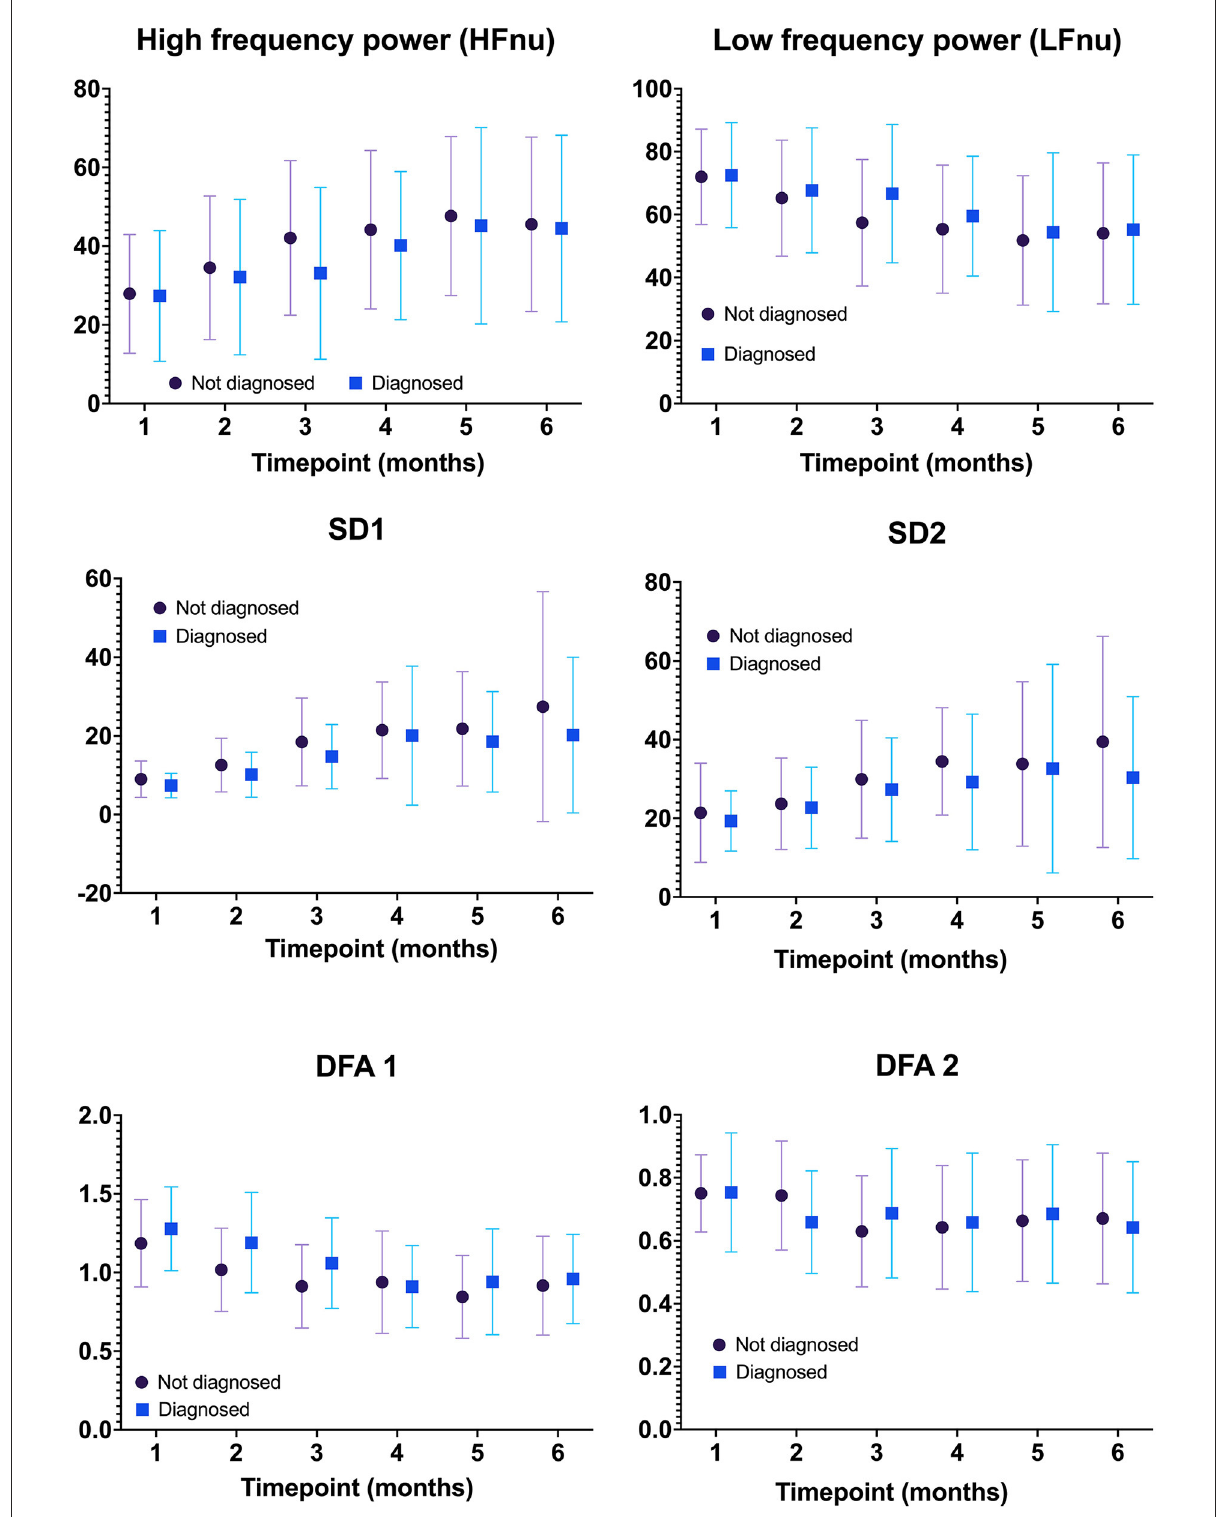
FIGURE2 Comparison of HRV metrics between infants with and without the diagnosis of IESS at each age group. There was no statistically significant difference in any HRV metric between infants with and without the diagnosis of IESS at all time points tested. IESS, Infantile epileptic spasm syndrome; HRV, heart rate